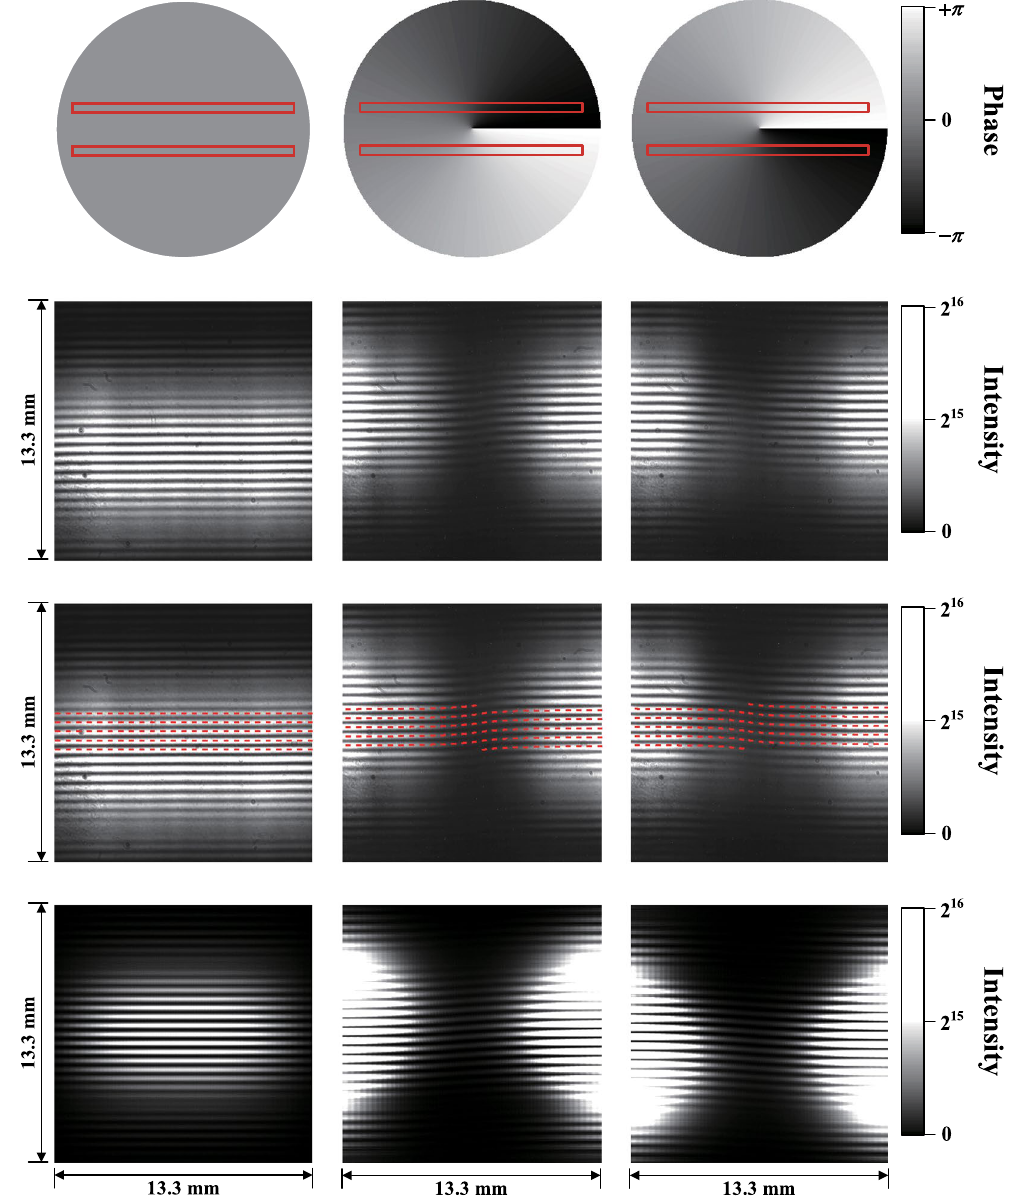
Figure 5. Double-slit diffraction patterns of undulator radiation. From the left column to the right; the fundamental, the second harmonic (left-handed) and the second harmonic (right-handed), from the top row to the bottom; schematic drawings of the double-slits (red rectangles) and the phase distributions, the raw CCD camera images, those with the analytic calculation following Sztul and Alfano 24 (red dotted lines) and the SRW simulation results 25 . The handedness is defined as same as in Fig. 4. The centres of the analytic calculation results are fitted to the